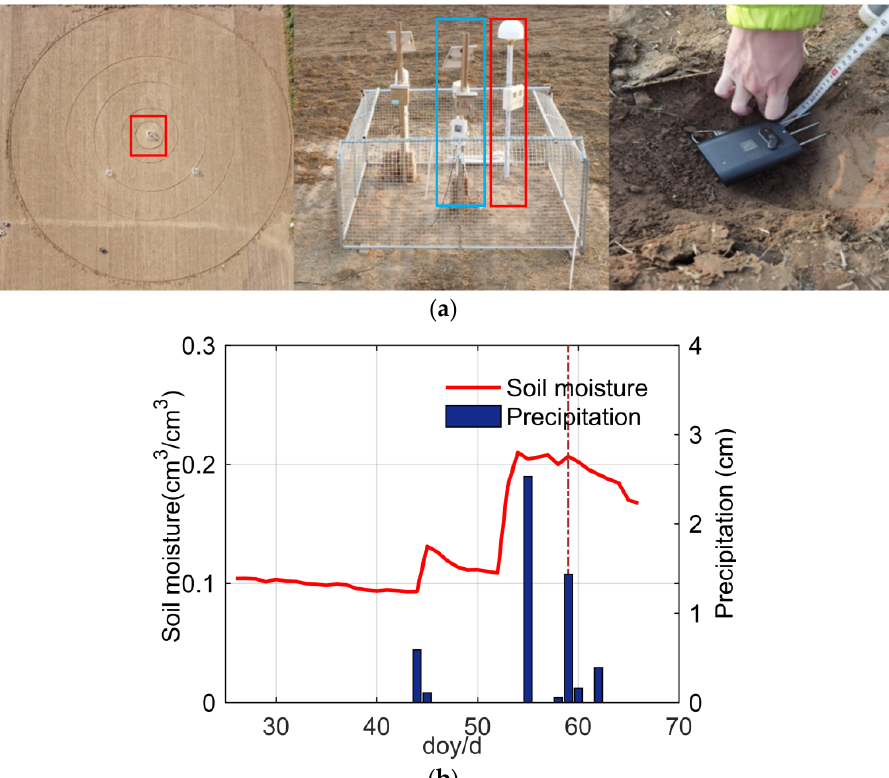
Figure 8. ( a ) Instrument and equipment ( mid ), surrounding environment ( left ), and soil moisture sensor ( right ). The red box represents the antenna and receiver; the blue box represents power supply equipment. ( b ) The soil moisture-rainfall diagram during the experimental period.